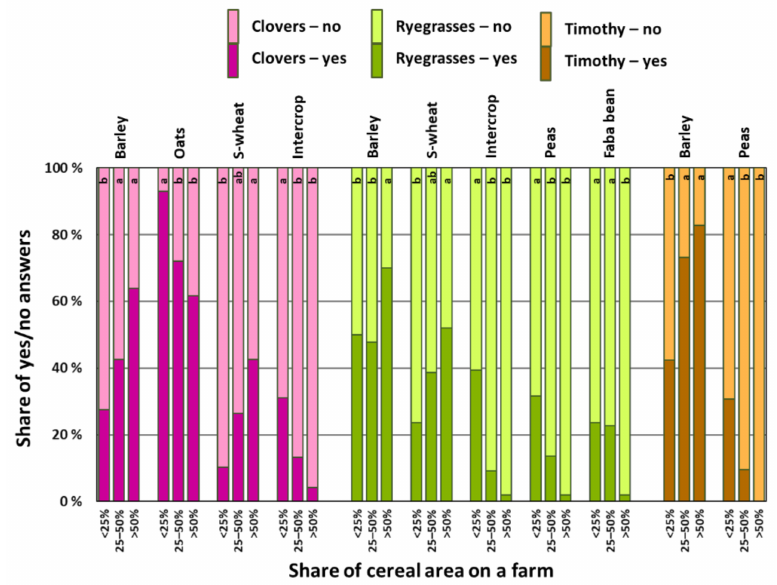
Figure 4. Impacts of the share of cereal area on a farm on cash crop and under-sown cover crop (CC) group combinations in Finland. Only significant differences with a p -value ≤ 0.05 are shown. Means with the same letter for each cereal area group and CC cash crop combination do not differ